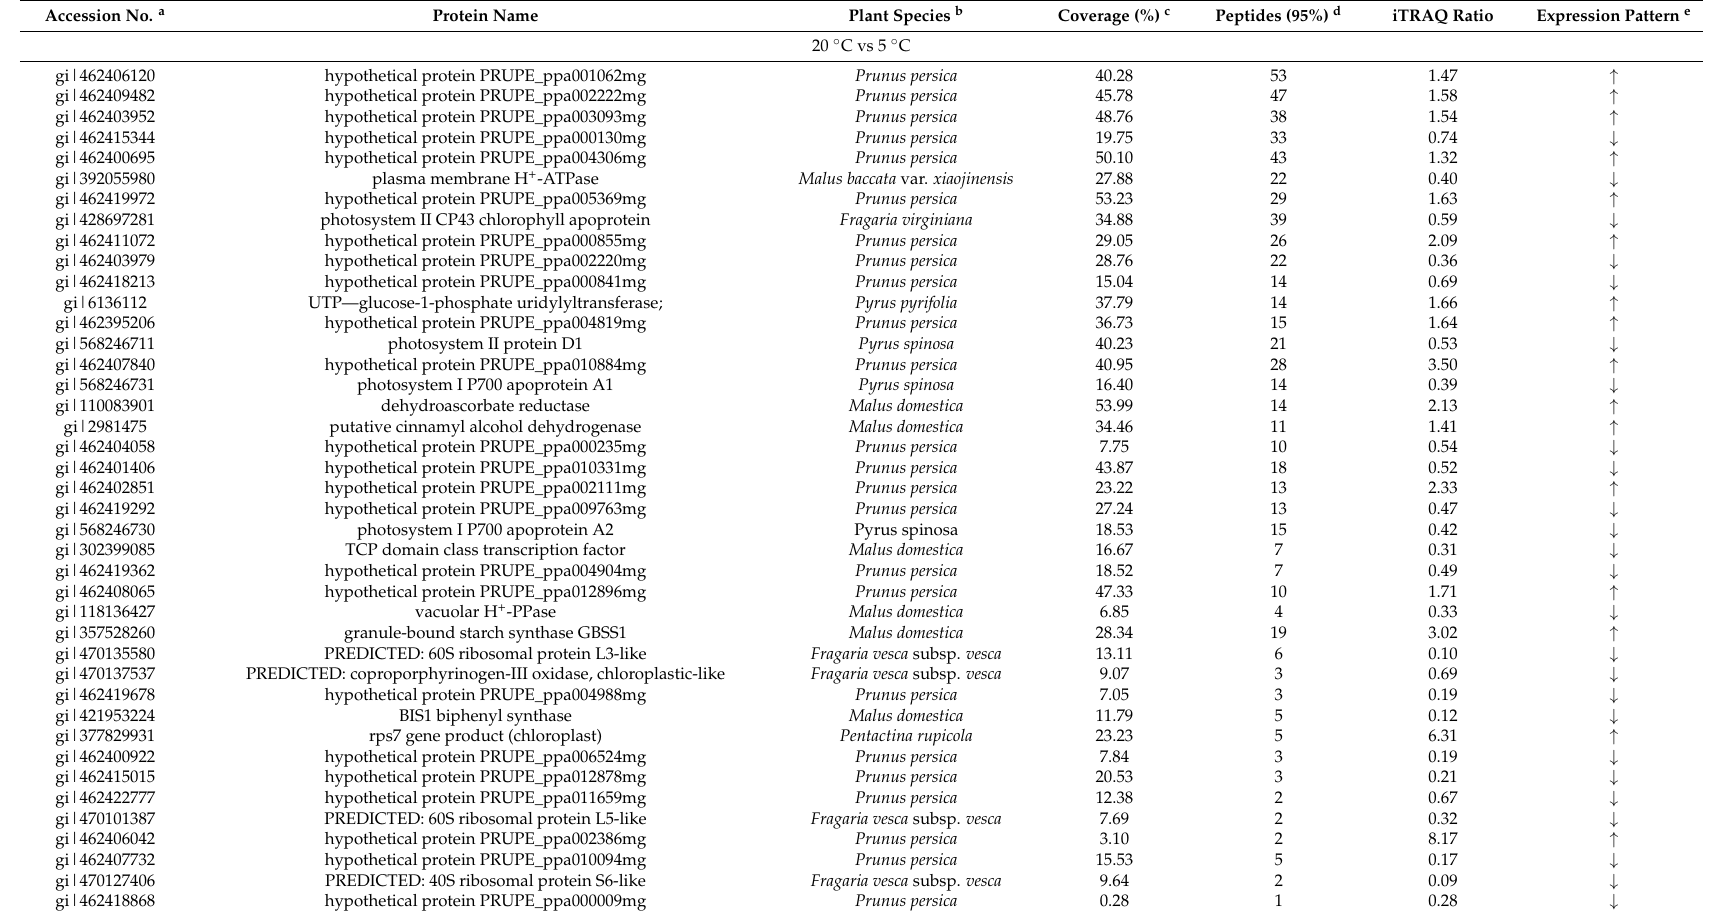
Table 2. List of differentially abundant proteins in M. baccata leaves under different